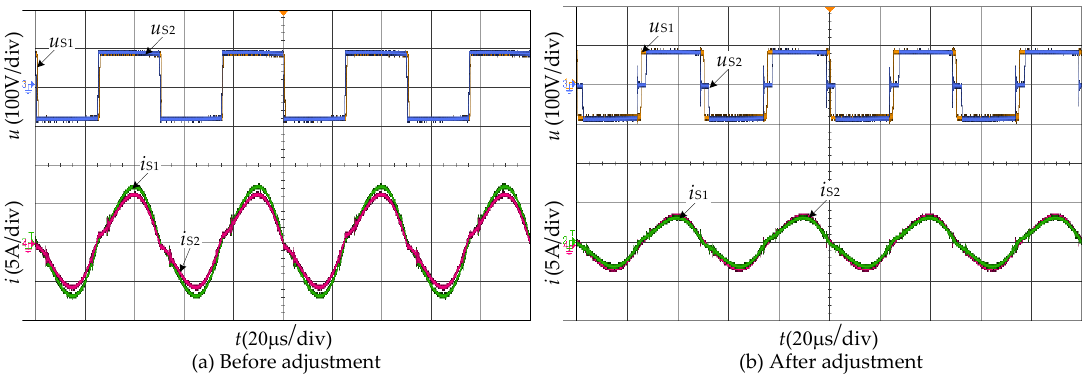
Figure 14. Input voltage and current waveforms of the receivers when the load is 10 Ω and δ equals 100 mm. Energies 2017 , 10 , 217